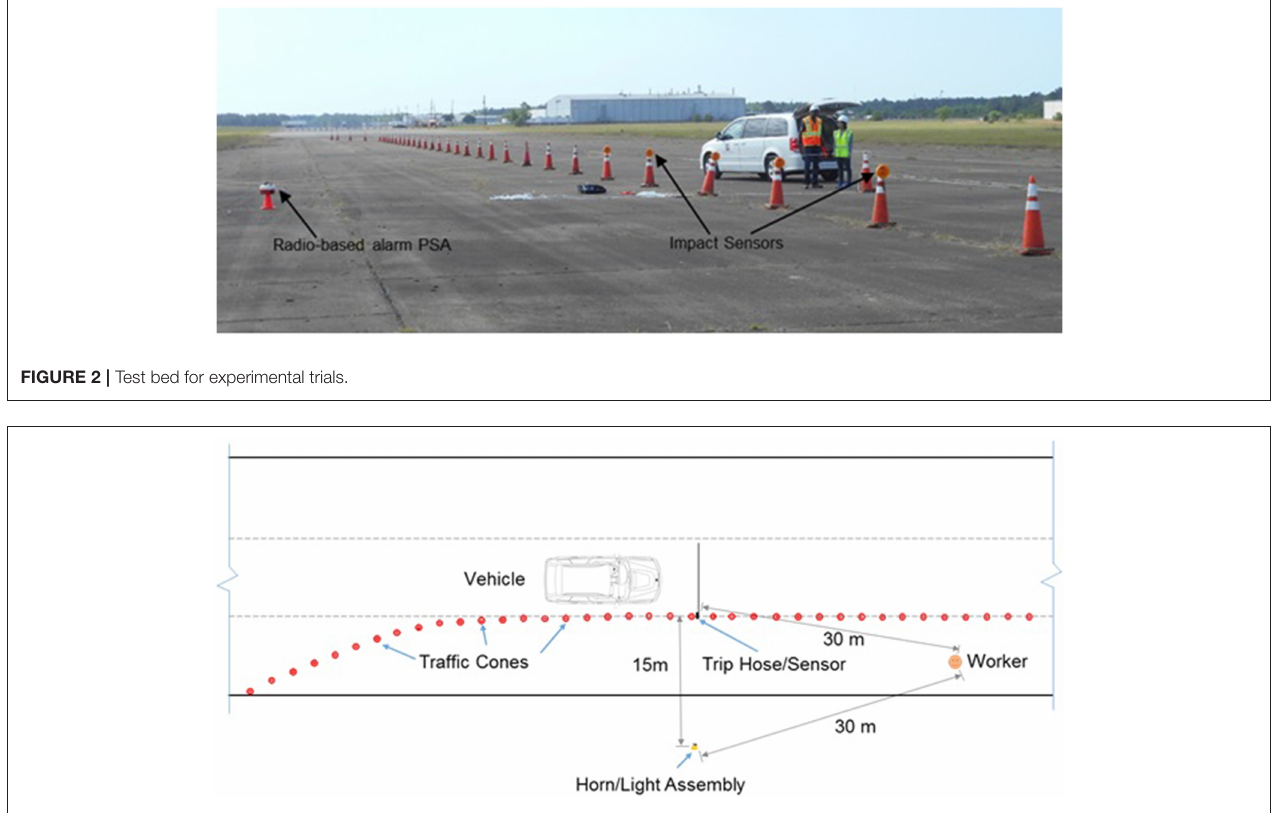
FIGURE 3 | Layout of the experimental trials